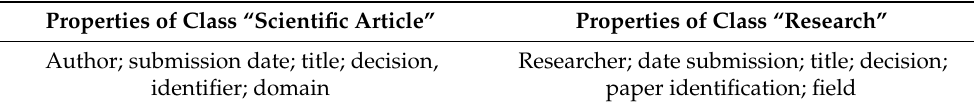
Table 4. Data properties after removing the class signs.